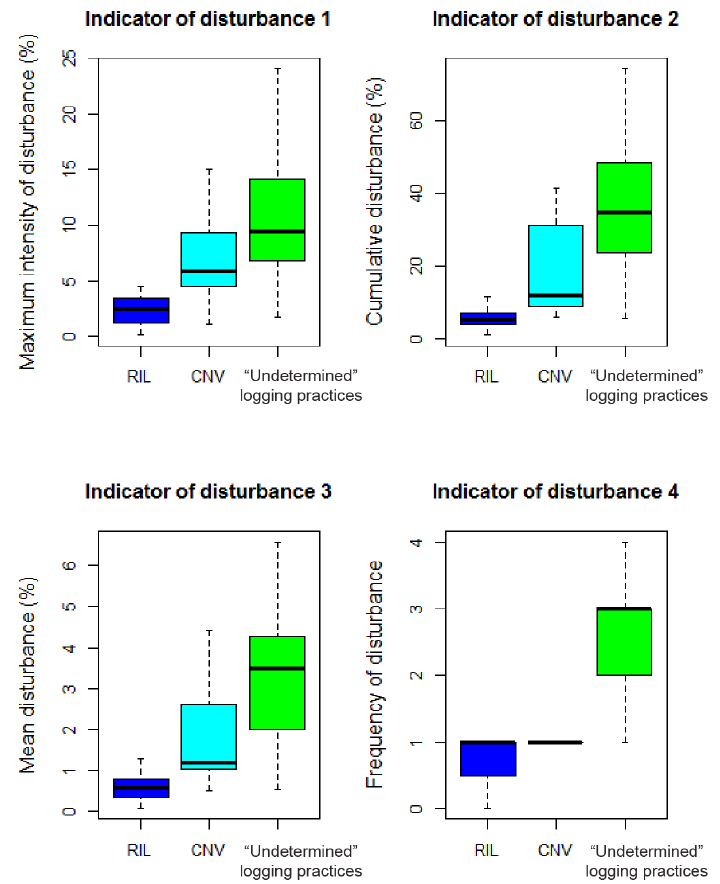
Figure 4. Disturbance indicators in function of forest management techniques for a 15 year period. (i) In dark blue: plots with Reduced Impact Logging (RIL) practices; (ii) in cyan: plots with conventional management (CNV) practices; and (iii) in green: plots with “undetermined” logging practices (the plots are situated in private forested rural properties registered in the CAR (Rural Environmental Cadastre— Cadastro Ambiental Rural ).